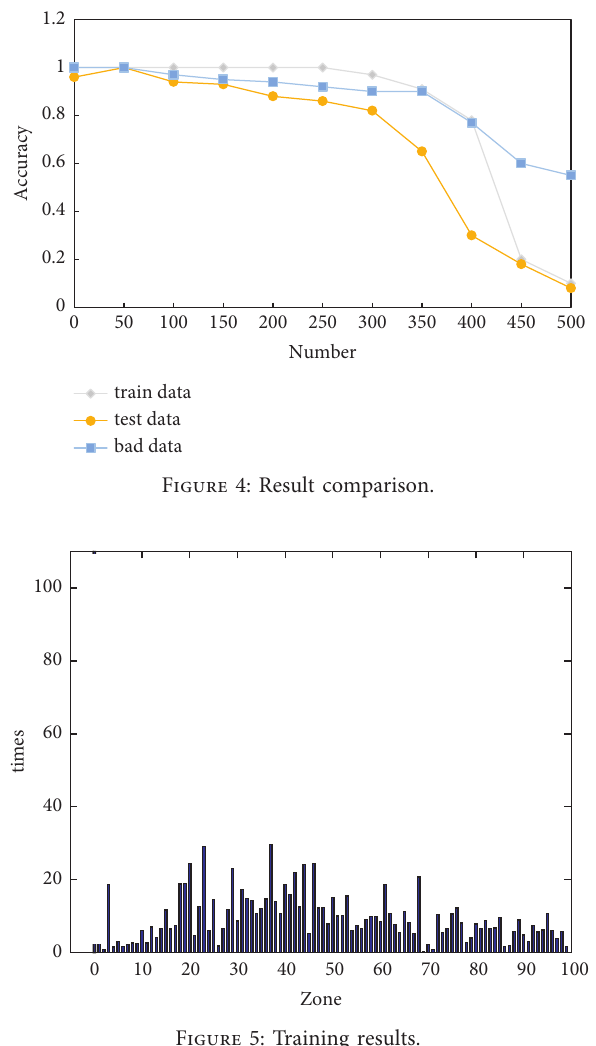
Figure 5: Training